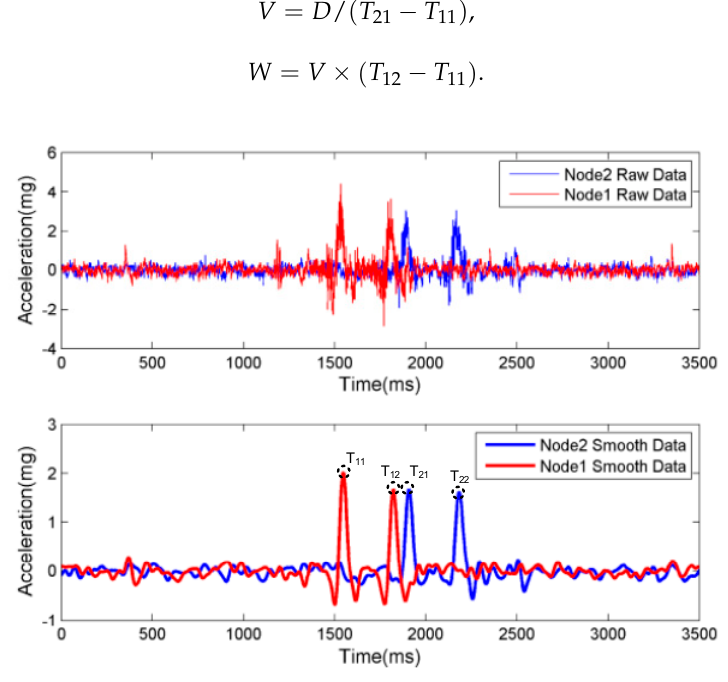
Figure 10. The pavement vibration response while a vehicle passes.